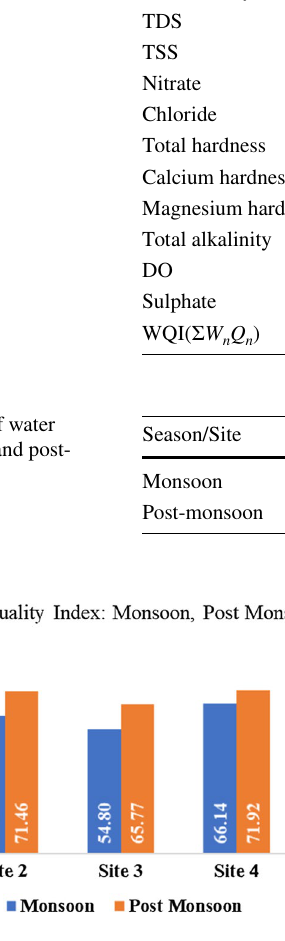
Fig. 2 Variation of water quality index for sites in monsoon and post- monsoon